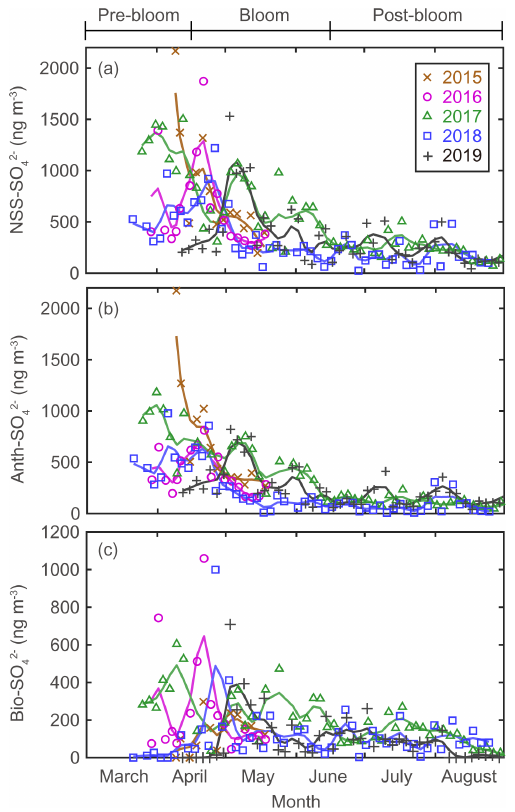
Figure 4. Aerosol concentrations for (a) NSS-SO 2 − minus SS-SO 2 − ), (b) Anth-SO 2 − , and (c) Bio-SO 2 − 4 4 solid lines indicate 15d moving average